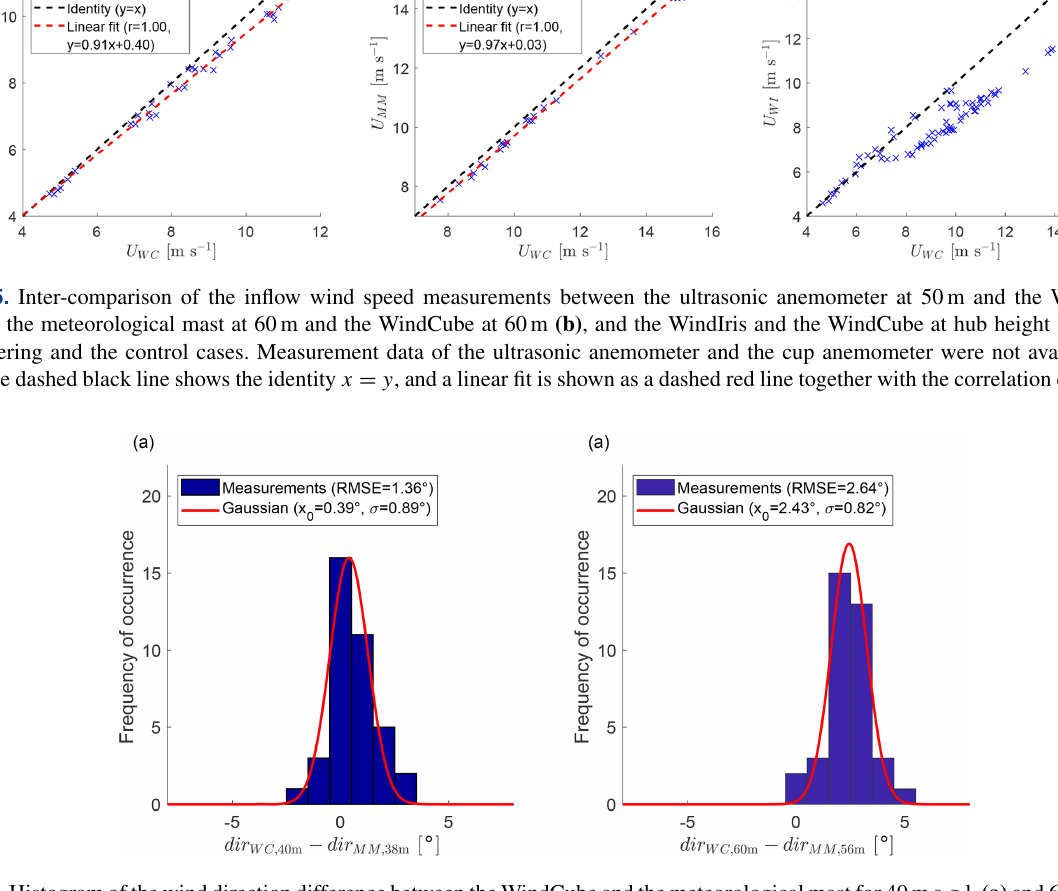
Figure 6. Histogram of the wind direction difference between the WindCube and the meteorological mast for 40ma.g.l. (a) and 60ma.g.l. (b) using the wake-steering and the control cases after 16 February 2019 (the wind vanes on the meteorological mast were misaligned before 16 February 2019). The red line shows a Gaussian fit to the